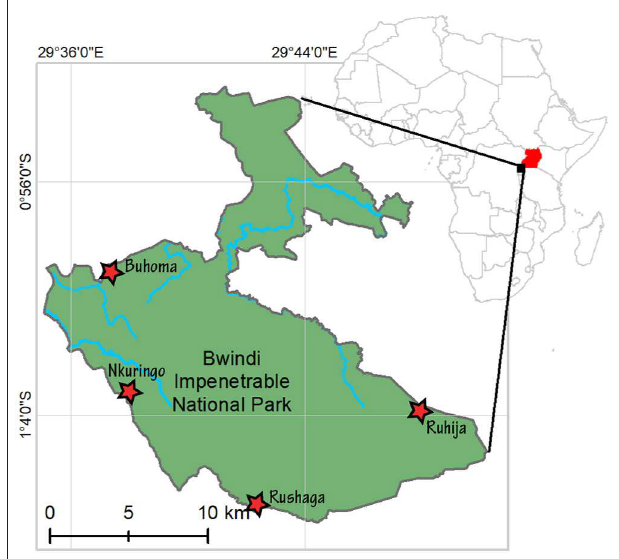
FIGURE 1 | Study location: Bwindi Impenetrable National Park, Uganda. Stars indicate locations of trekking trail heads.